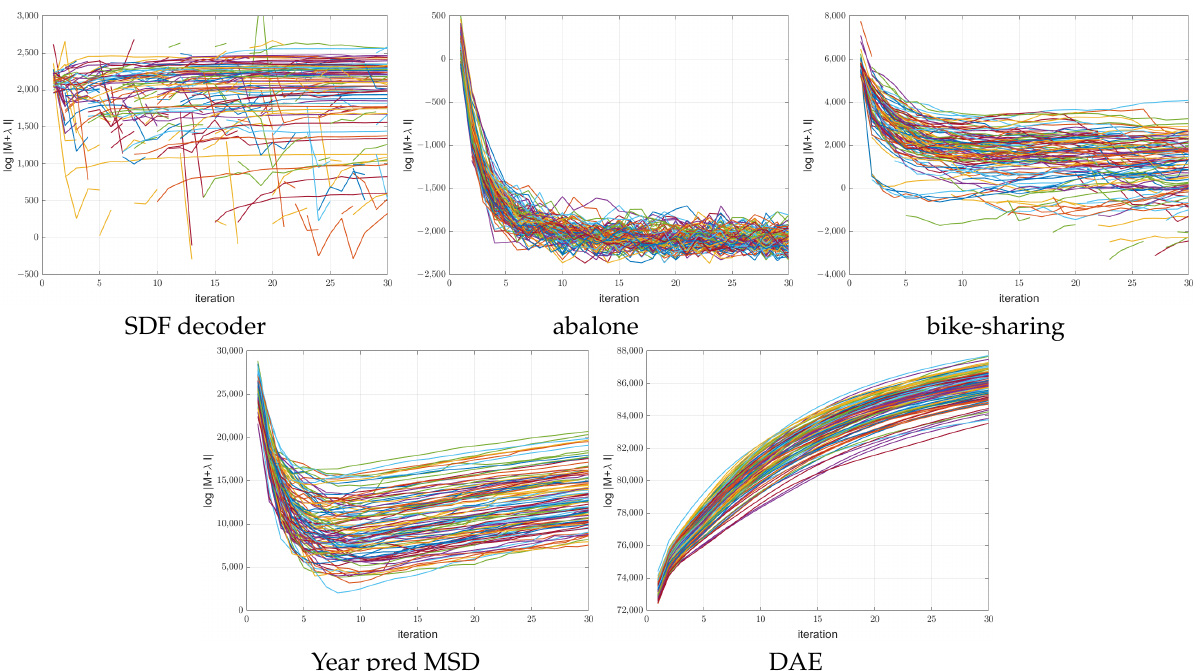
Figure 11. Plot of the ln | M + λ I ( d + 1 ) h | vs. iteration number for the 100 ANMIN (Algorithm 1) runs for NN with leaky ReLU activation. The different runs are shown in different